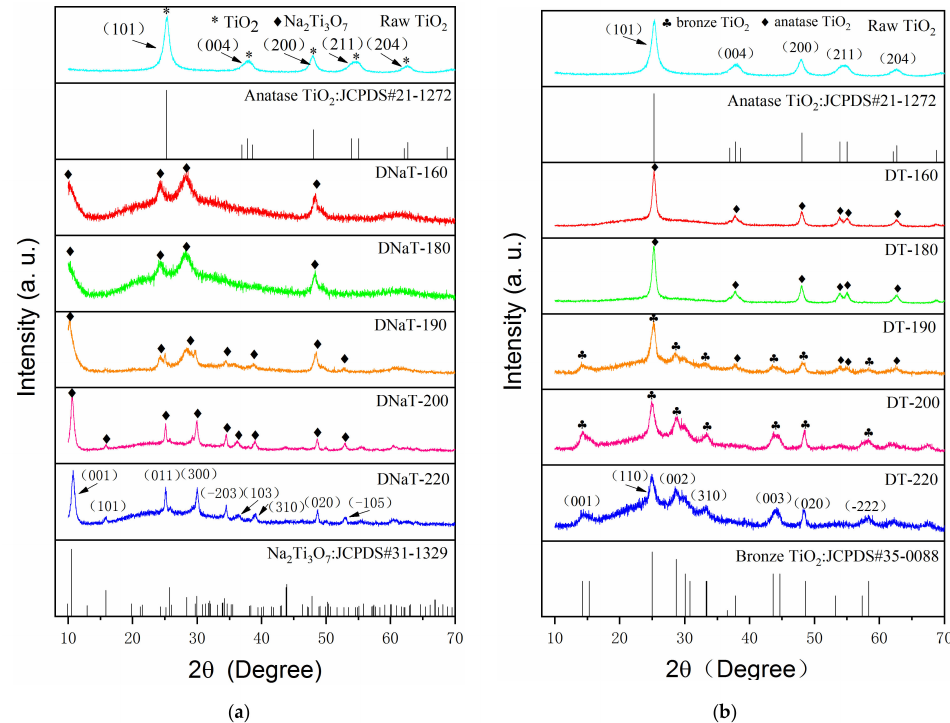
Figure 1. XRD diffraction patterns of the ( a ) intermediate products, * represents the diffraction peak of anatase TiO 2 , ◆ represents the diffraction peak of Na 2 Ti 3 O 7 and ( b ) final products, ♣ represents the diffraction peak of bronze TiO 2 , ◆ represents the diffraction peak of anatase TiO 2. Figure 2a–d shows the scanning electron microscopy (SEM) images of the DNaT ‐ 200, DNaT ‐ 190, DNaT ‐ 180, and DNaT ‐ 160, respectively. Figure 2e–h shows the SEM images of the DT ‐ 200, DT ‐ 190, DT ‐ 180, and DT ‐ 160, respectively. The comparison of the two sets of SEM images shows that the morphologies of the final products (DT ‐ 200 through DT ‐ 160) and the intermediate products (DNaT ‐ 200 through DNaT ‐ 160) remained the same and unchanged. Combined with the XRD analysis results, we concluded that the band ‐ like material in the two sets of SEM images was Na 2 Ti 3 O 7 (Figure 2a,b), which retained this morphology after ion exchange and calcination (Figure 2e,f) but was converted to TiO 2 (B). These band ‐ like Na 2 Ti 3 O 7 and TiO 2 (B) were also observed in samples DNaT ‐ 220 and DT ‐ 220, respectively. When the hydrothermal reaction temperature dropped to 190 °C, a three ‐ dimensional network started to appear in the DNaT ‐ 190 and DT ‐ 190 samples and many fine particles were dispersed on the network; these were TiO 2 (A) crystals that had not been converted. As the hydrothermal reaction temperature was further reduced, the conversion rate of the raw TiO 2 to Na 2 Ti 3 O 7 decreased. When the hydrothermal reaction temperature decreased to 180 °C, band ‐ like Na 2 Ti 3 O 7 could no longer be generated by the reaction. Morphologically, the product consisted of Na 2 Ti 3 O 7 with a network structure and granular TiO 2 (A) dispersed in the network structure that had not completely reacted, as shown in Figure 2c,d,g,h, respectively.